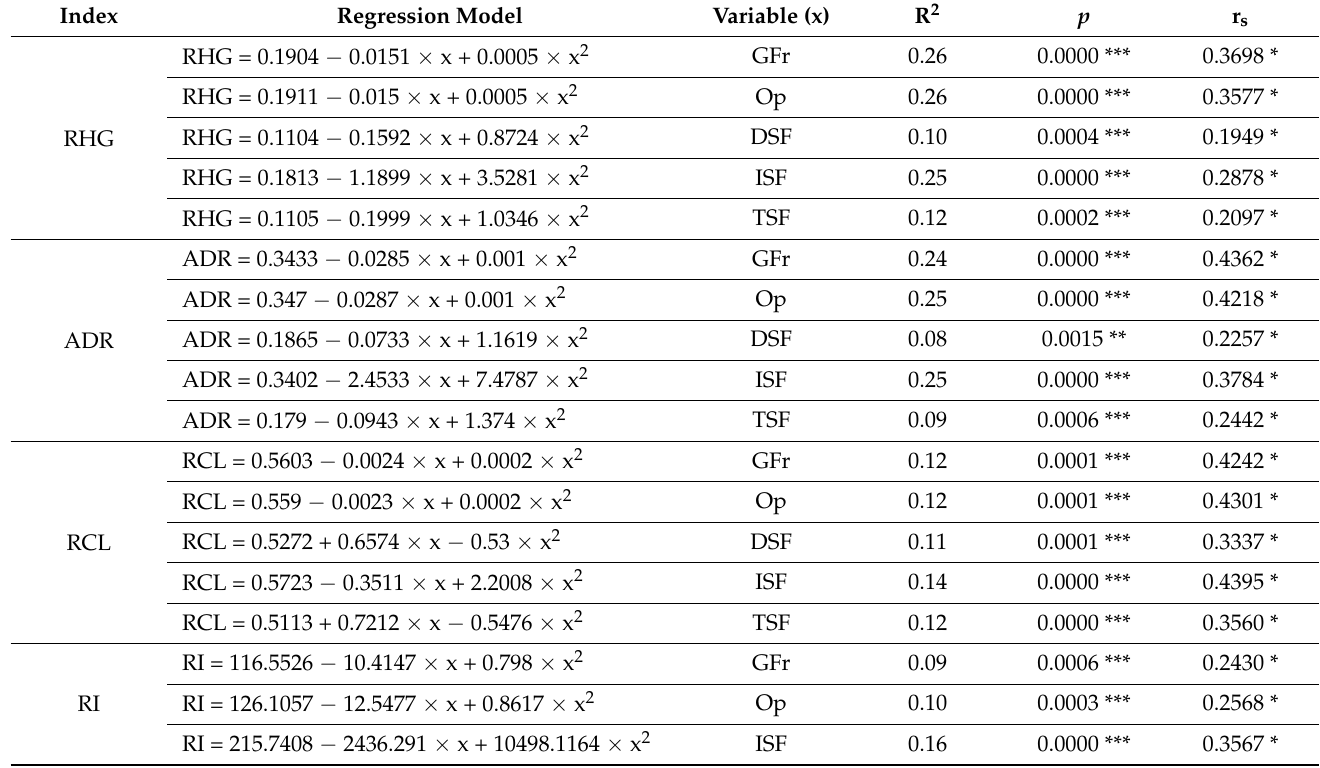
Table 5. Significantly proven regression models of light intensities and photo-morphological acclima- tions of Norway spruce natural regeneration under size-independent